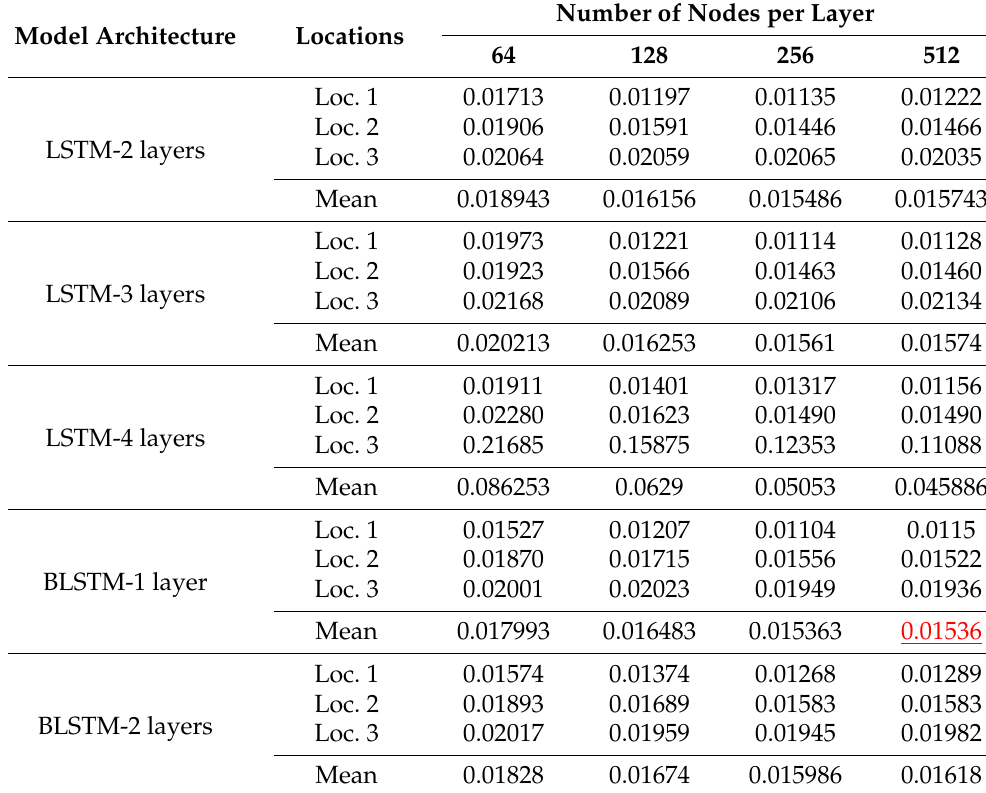
Table 3. Validation MSE for different number of LSTM layers and LSTM nodes per layer.